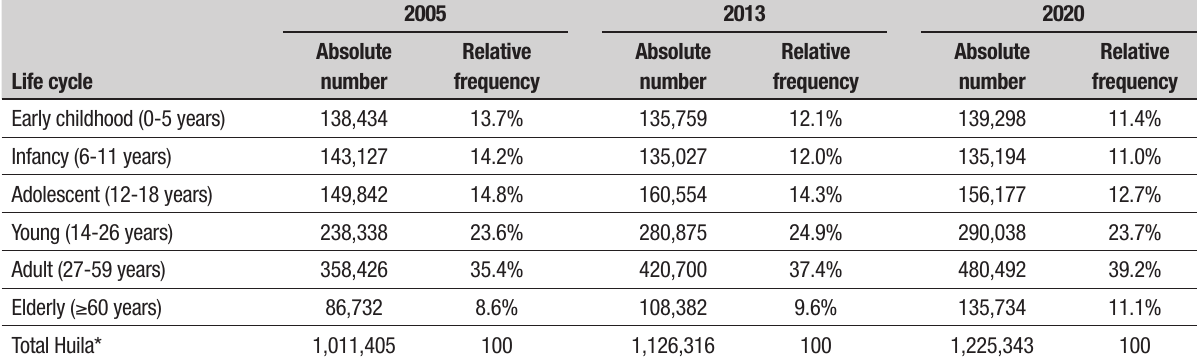
Table 1. Proportion of the population life cycle Huila department 2005, 2013 and